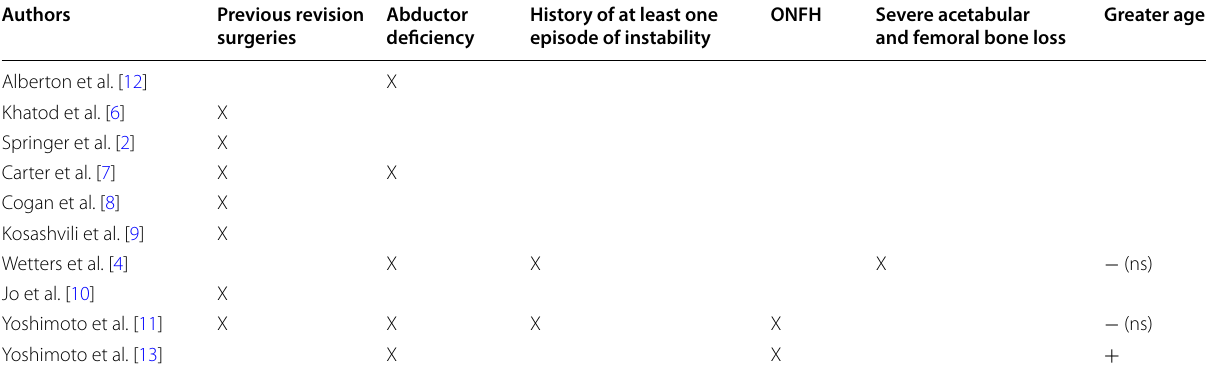
Table 1 Patient-related risk